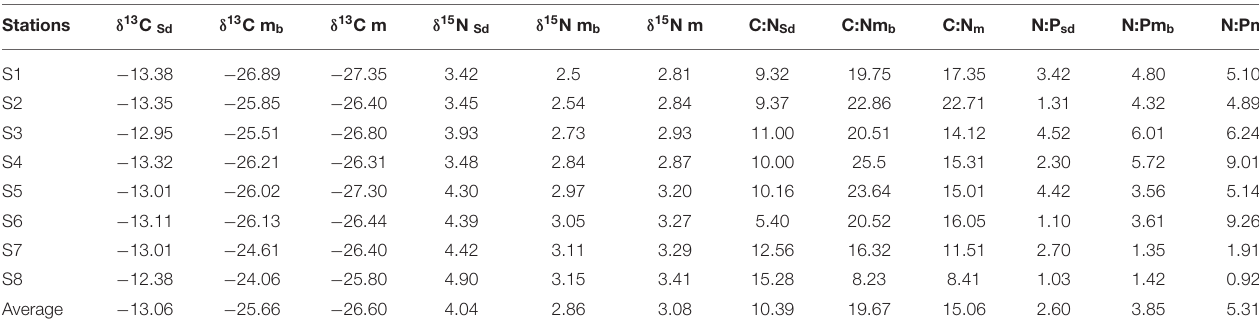
TABLE 3 | Stable isotopes, C:N and N:P in sediment and mangrove A. marina .